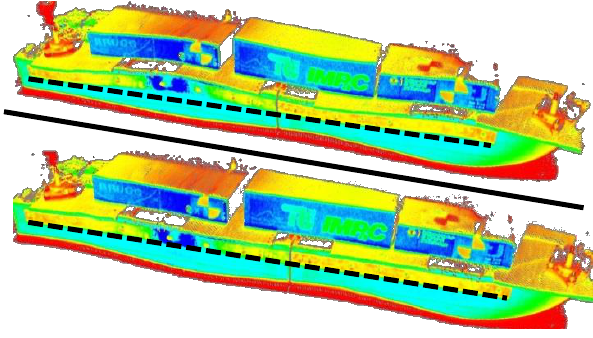
Figure 6: Point cloud of the kinematically acquired boat before (upper part) and after geometric correction (lower part)